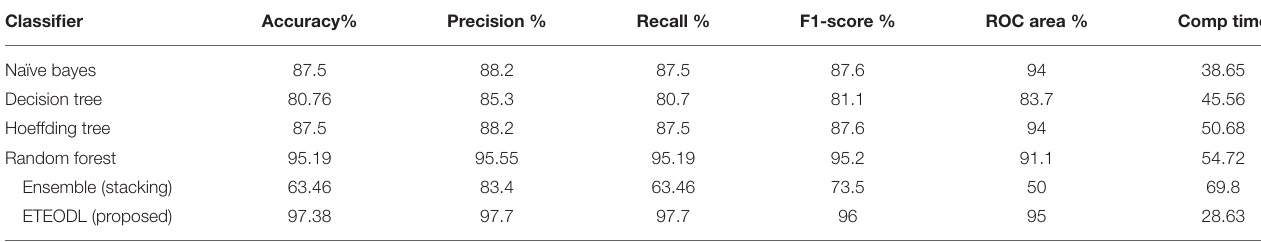
TABLE 2 | Comparison of proposed model with conventional ML algorithms. Classifier